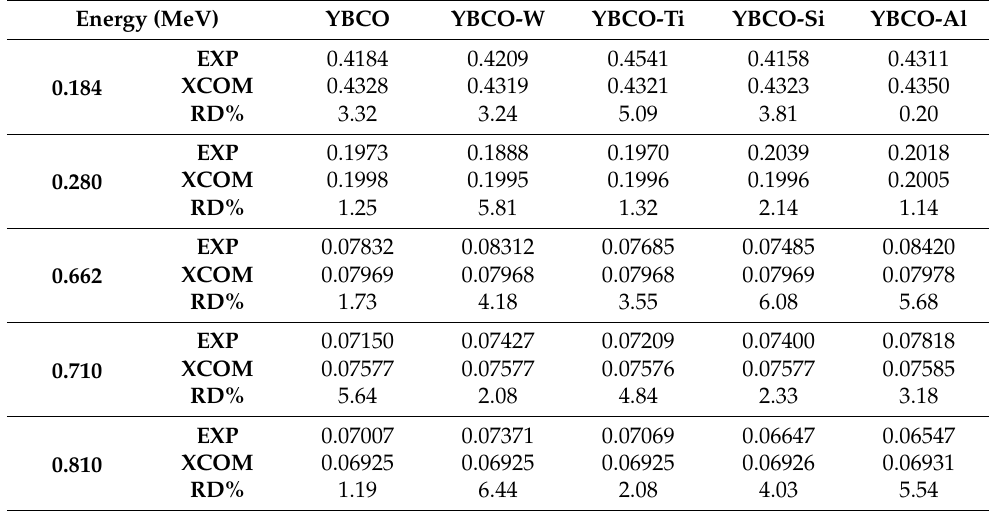
Table 2. Comparison among theoretical and experimental values of MAC at diverse energies. Energy